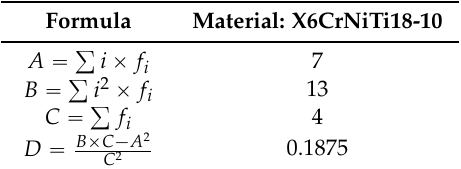
Table 5. Calculation of the constants A , B , C , D in accordance with ISO